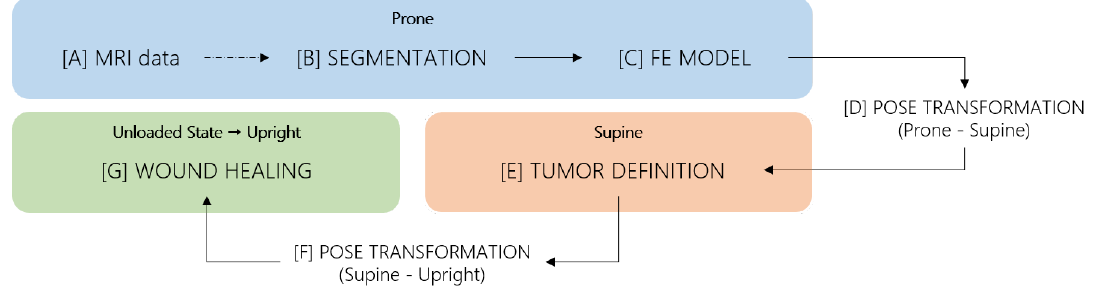
Figure 2. BCS simulation followed pipeline, as proposed by Vavourakis et al. [24].